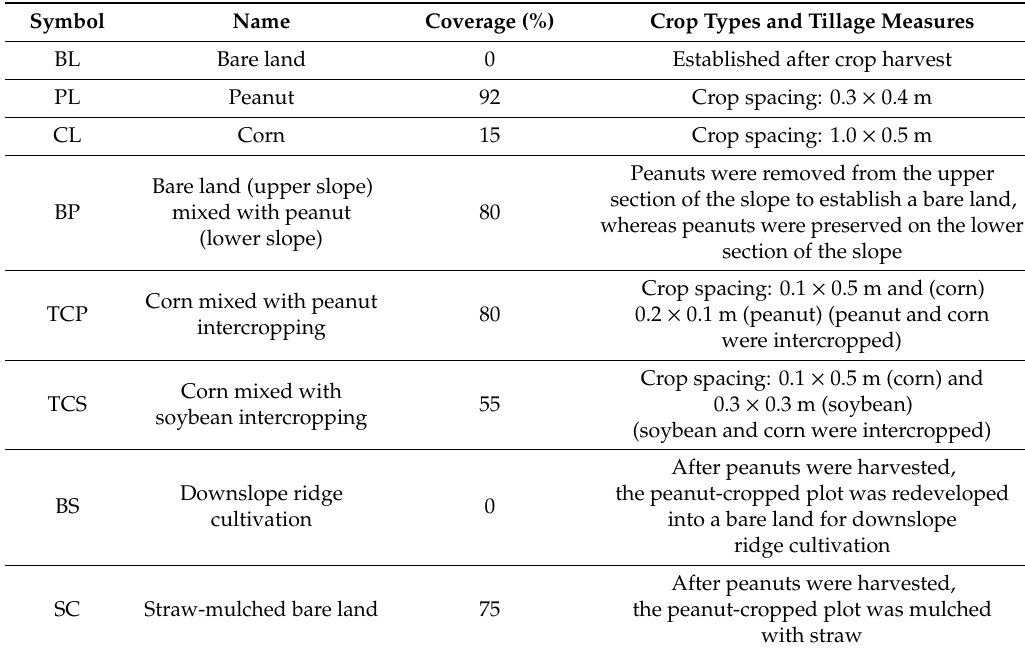
Table 1. Design of land cover types and tillage measures for artificial rainfall experiments Symbol Name Coverage (%)